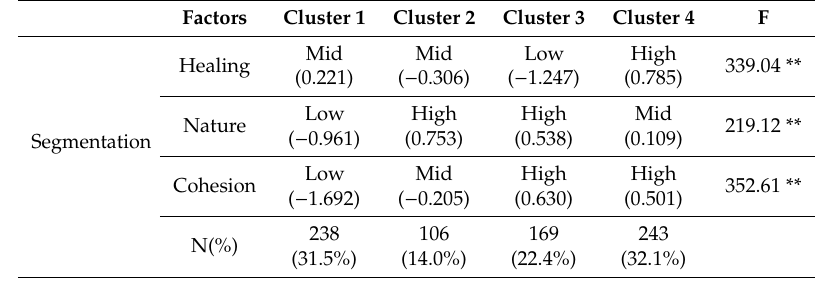
Table 3. Motivation-based segmentation.